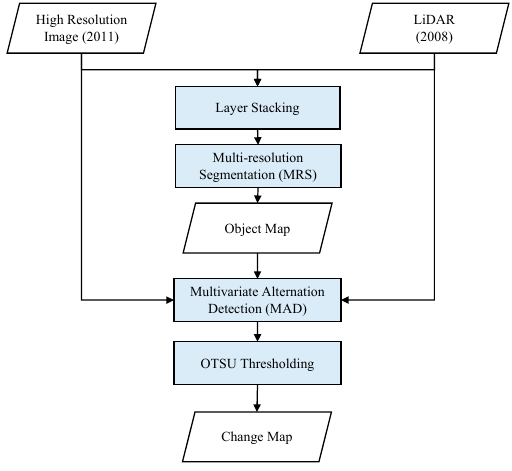
Figure 4. Flowchart of change detection with multi-temporal LiDAR data and high-resolution image. The multi-sensor data were firstly stacked and segmented by multi-resolution segmentation (MRS) algorithm. The object based data were processed by multivariate alteration detection (MAD) algorithm and OTSU thresholding to obtain the binary change